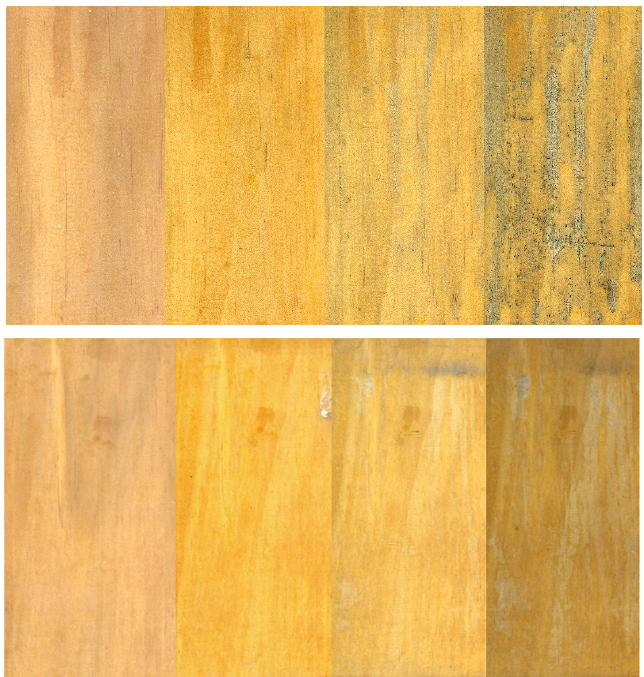
Figure 13. Examples of the same acetylated wood specimen treated with S1 and exposed outdoors on a test fence near Corvallis, OR, for 0, 6, 12, and 18 months ( top row ) and a similarly treated sample exposed at Madras, OR, for 0, 6, 15, and 25 months ( bottom row ).